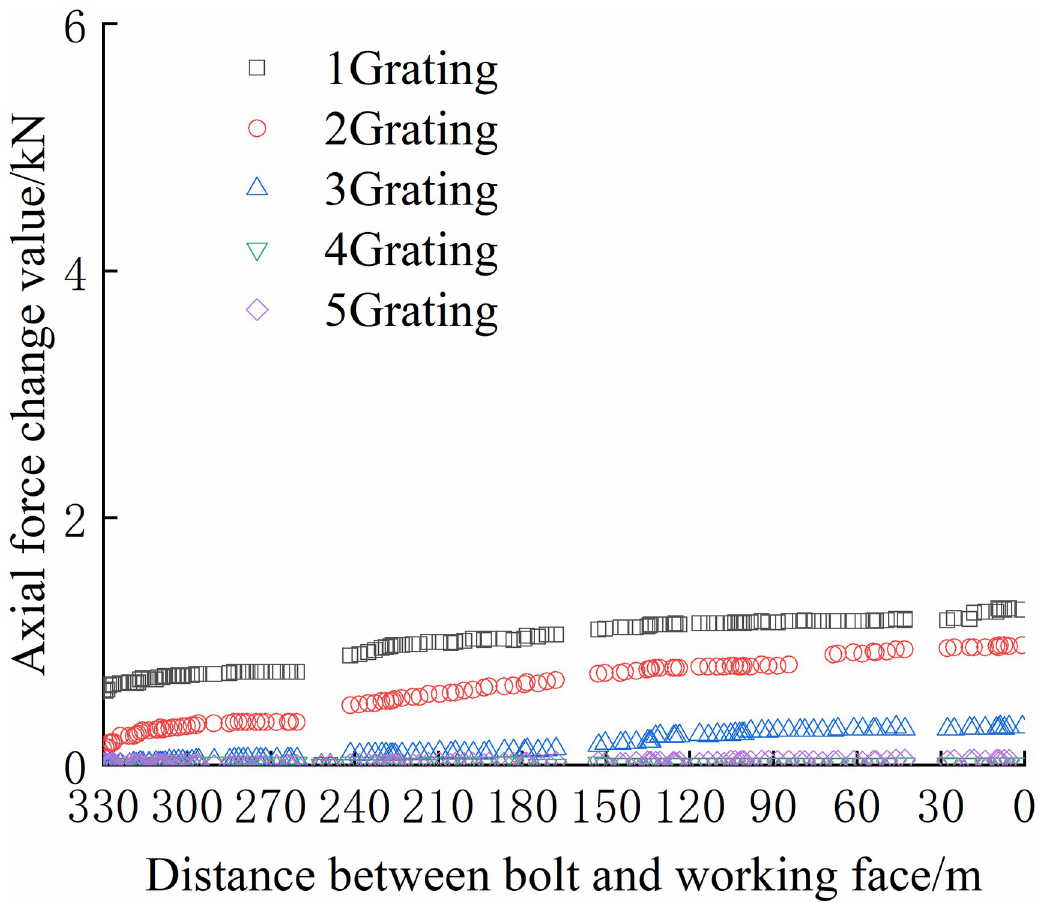
Fig 35. Axial force monitoring test curve of No. 12 bolt.